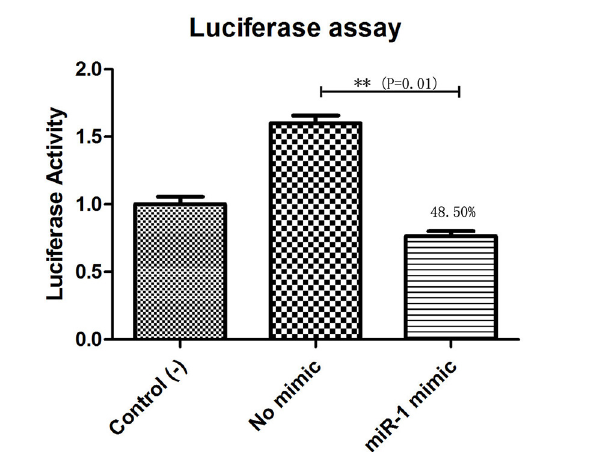
FIGURE 7 | Hsp60 is a target of miR-1. Dual luciferase reporter assay results are represented as the mean ± SEM of triplicate samples. The recombinant plasmid pmirGLO containing the Hsp60 gene was transfected into 293T cells. Expression of Hsp60 was measured by qPCR. Data are presented as the mean ± SEM of triplicate samples. ∗∗ P ≤ 0.01 (Student’s t